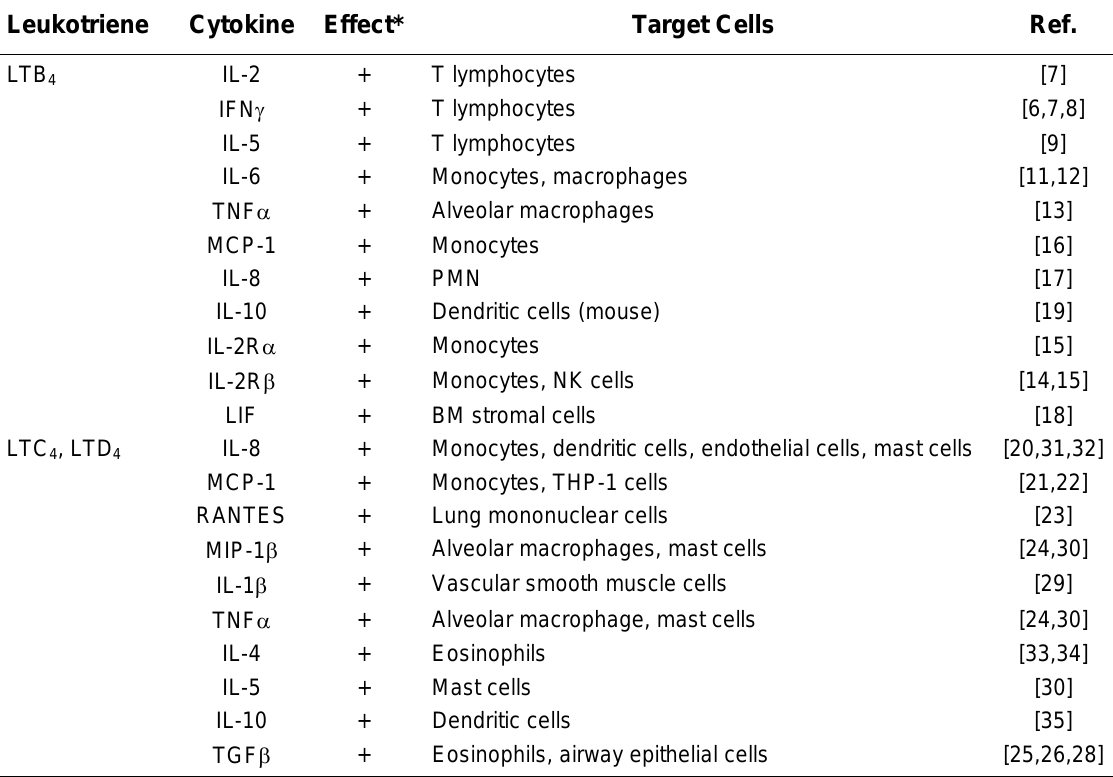
Leukotriene-Induced Modulation of Cytokine Expression Leukotriene